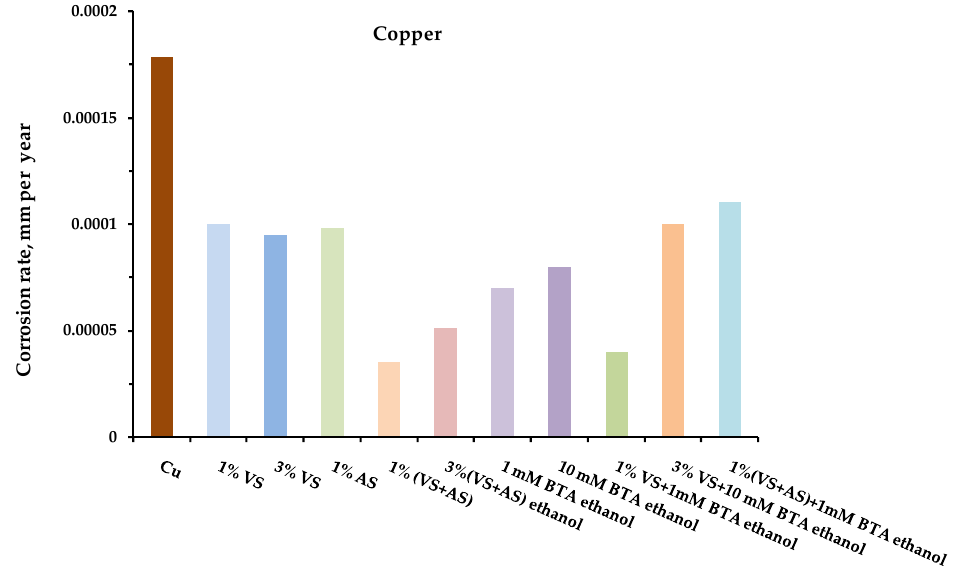
Figure 2. Atmospheric corrosion rates (mm per year) of copper modified by organosilane-based compositions. Full-scale, one-year corrosion tests, carried out in an urban atmosphere. Gravimetric assessment of corrosion